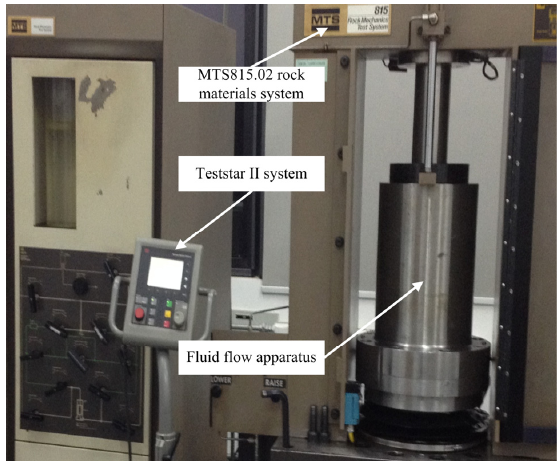
Figure 1. MTS815.02 system and a fluid seepage apparatus.